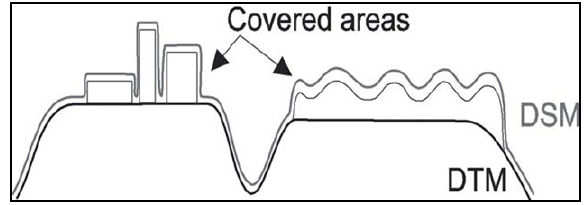
Figure 2. Difference between DTM (or DEM) and DSM